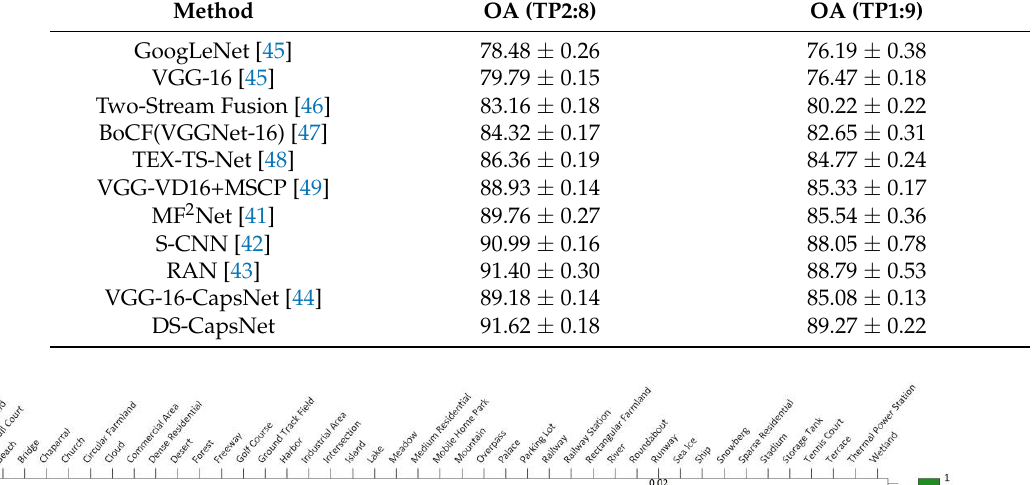
Table 3. OA (%) and SD of different methods under 2:8 and 1:9 training ratios on the NWPU- RESISC45 dataset.